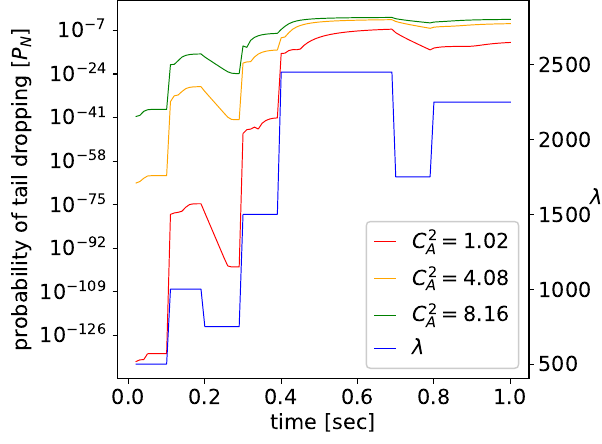
Figure 6. p N ( t ) for different C 2